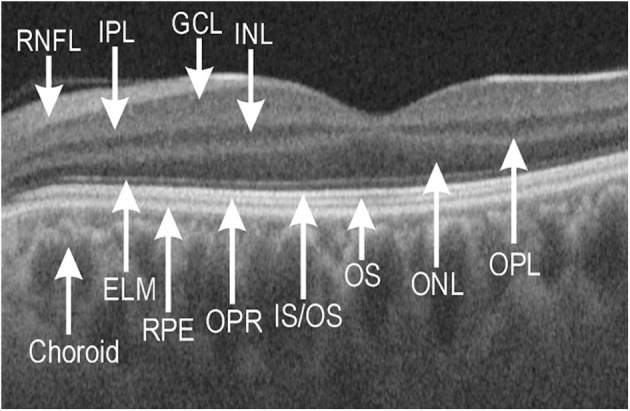
Representative optical coherence tomography (OCT) image of macular neuroretinal layers visualized by swept-source OCT and OCT-Explorer in a healthy control subject. ELM, external limiting membrane; GCL, ganglion cell layer; INL, inner nuclear layer; IPL, inner plexiform layer; IS/OS, junction of inner segment/outer segment of photoreceptor; ONL, outer nuclear layer; OPL, outer plexiform layer; OPR, outer segment of photoreceptor/retinal pigment epithelium complex; OS, outer segment; RNFL, retinal nerve fiber layer; RPE, retinal pigment epithelium.